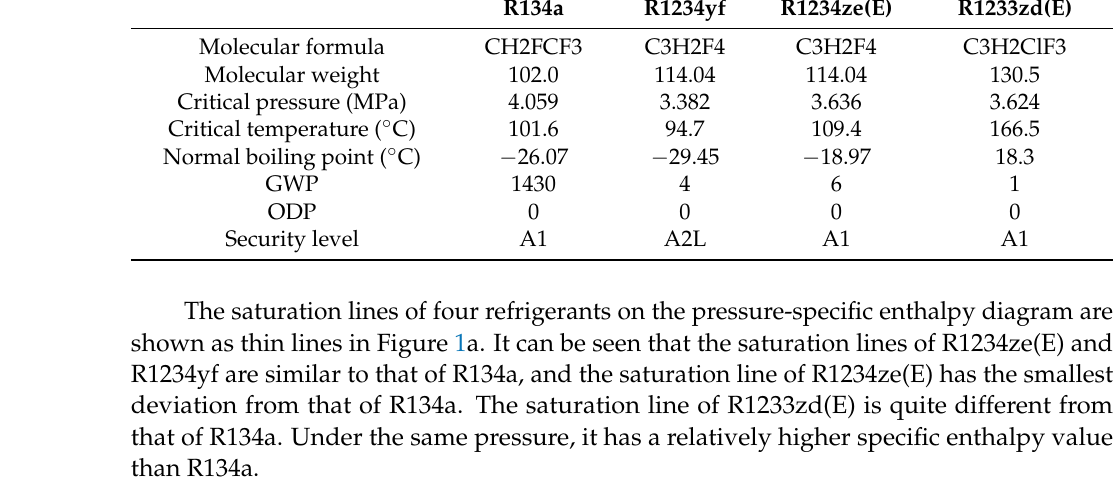
Table 1. Main physical property parameters of refrigerants.